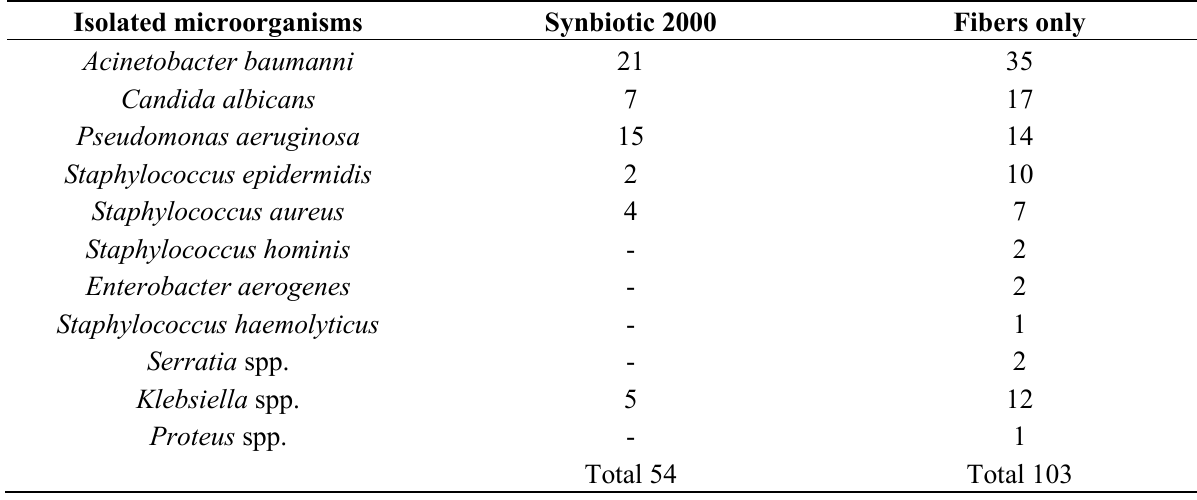
Table 10. Pathogens isolated from patients with polytrauma treated with Synbiotic 2000 and only the fibers in Synbiotic 2000, respectively